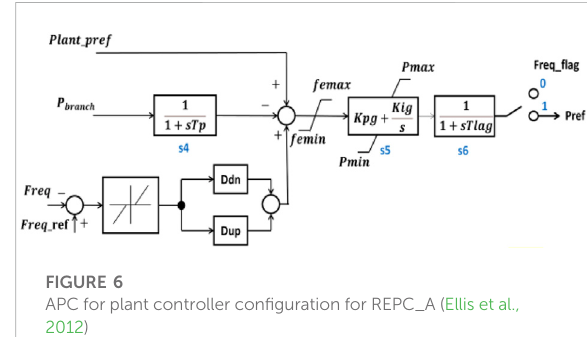
FIGURE 6 APC for plant controller con fi guration for REPC_A (Ellis et al.,